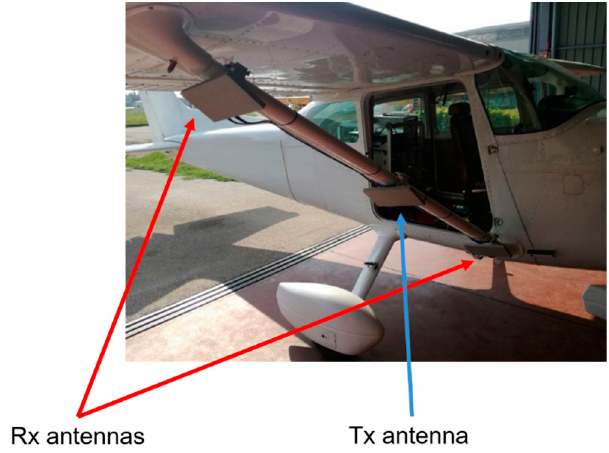
Figure 2. Interferometric layout of the AXIS system. The light blue arrow points to the transmitting radar antenna, whereas the red arrows point to the two receiving radar antennas.